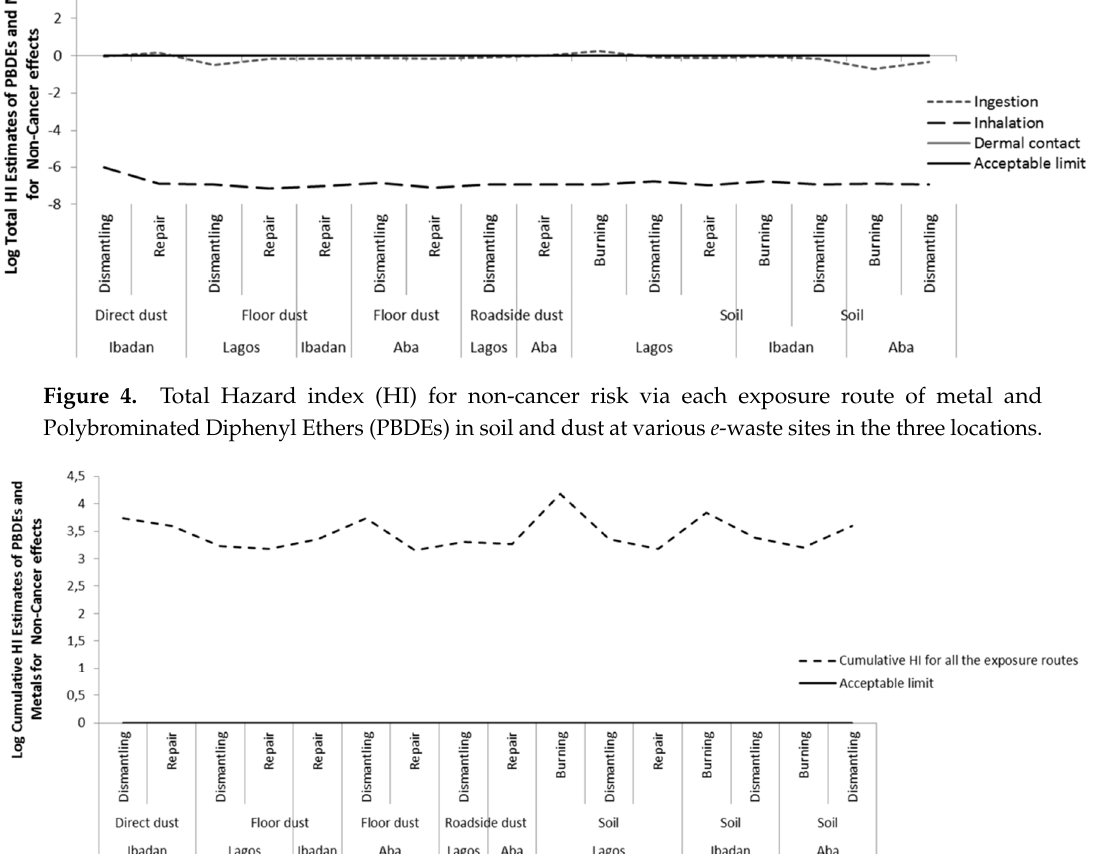
Figure 5. Cumulative Hazard index (HI) of all exposure routes for non-cancer risk of metal and PBDEs in soil and dust at various e -waste sites in the three locations.